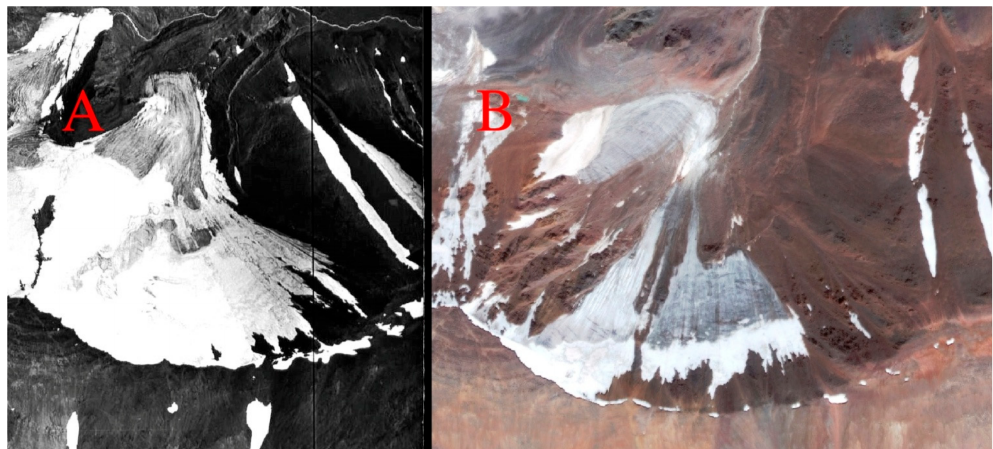
Figure 13. Degradation of a cirque glacier in the Ikh-Uygar-Barun-Sala valley, the Saylugem ridge. ( A ) Aerial image (24 August 1962); ( B ) satellite image Geoeye-1 (24 July